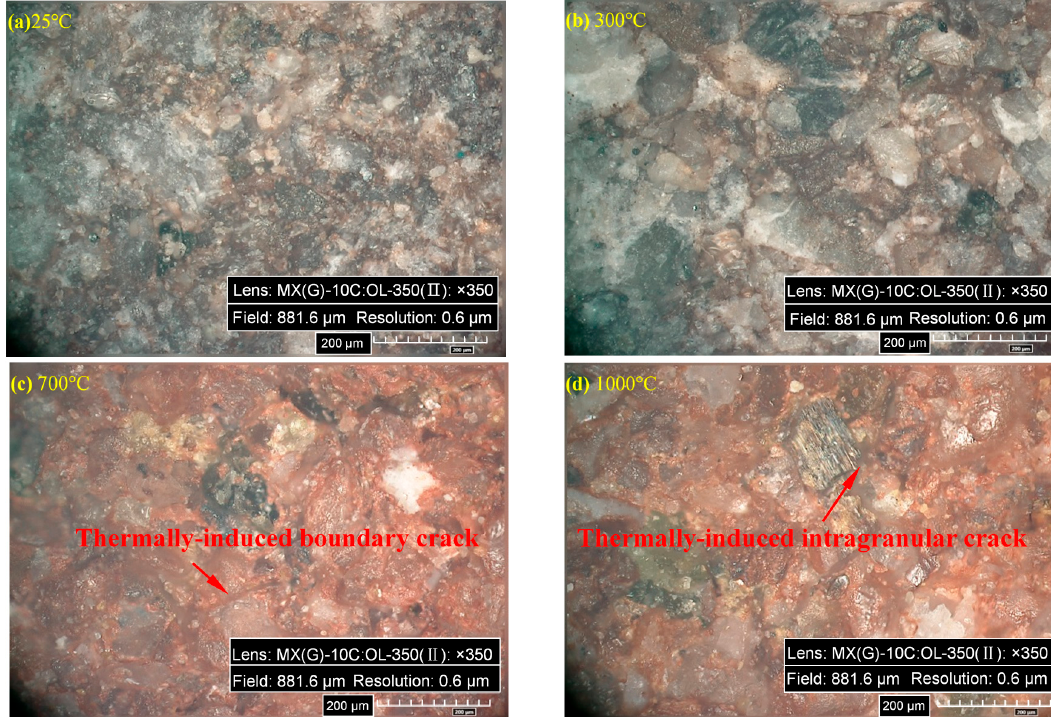
Figure 16. Critical stress ratio versus temperature.